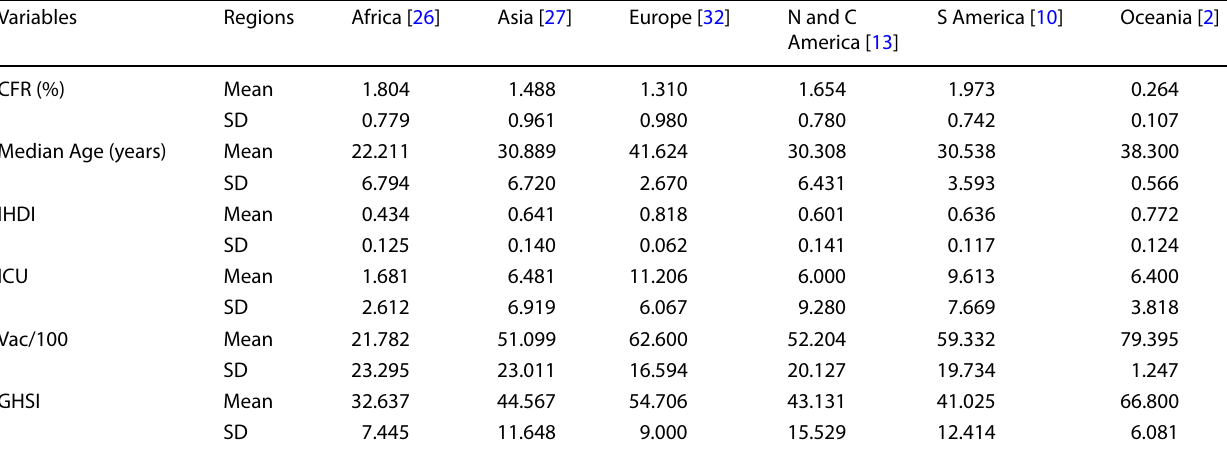
Table 2 Descriptive statistics for regional analysis of COVID-19 CFR and selected